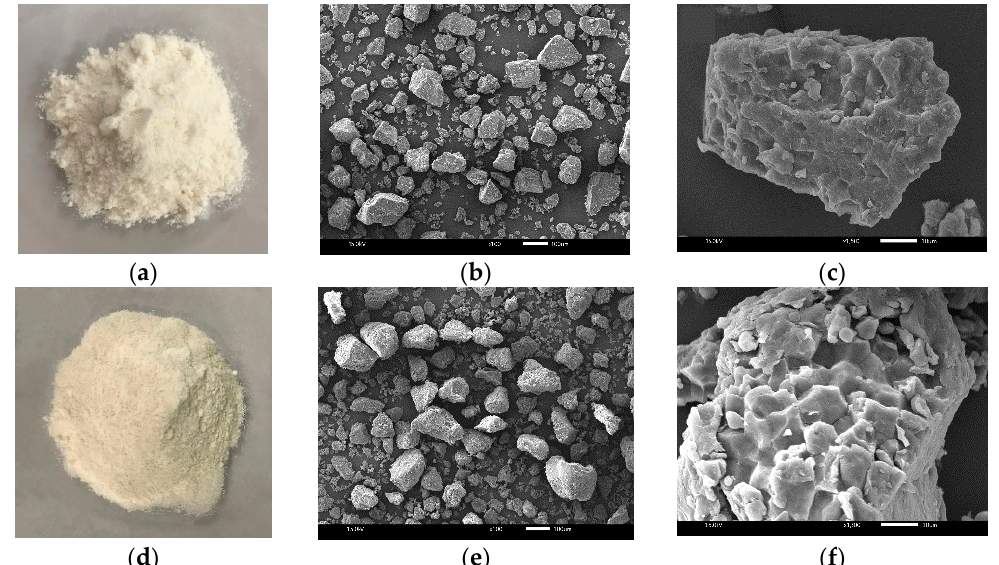
Figure 1. Photographs of ( a ) Hom Mali rice flour, and ( d ) RD43 rice flour. Scanning electron micrographs of Hom Mali flour, magnified ( b ) 100 × and ( c ) 1500 × , as well as RD43 rice flour, magnified ( e ) 100 × , and ( f ) 1500 × .